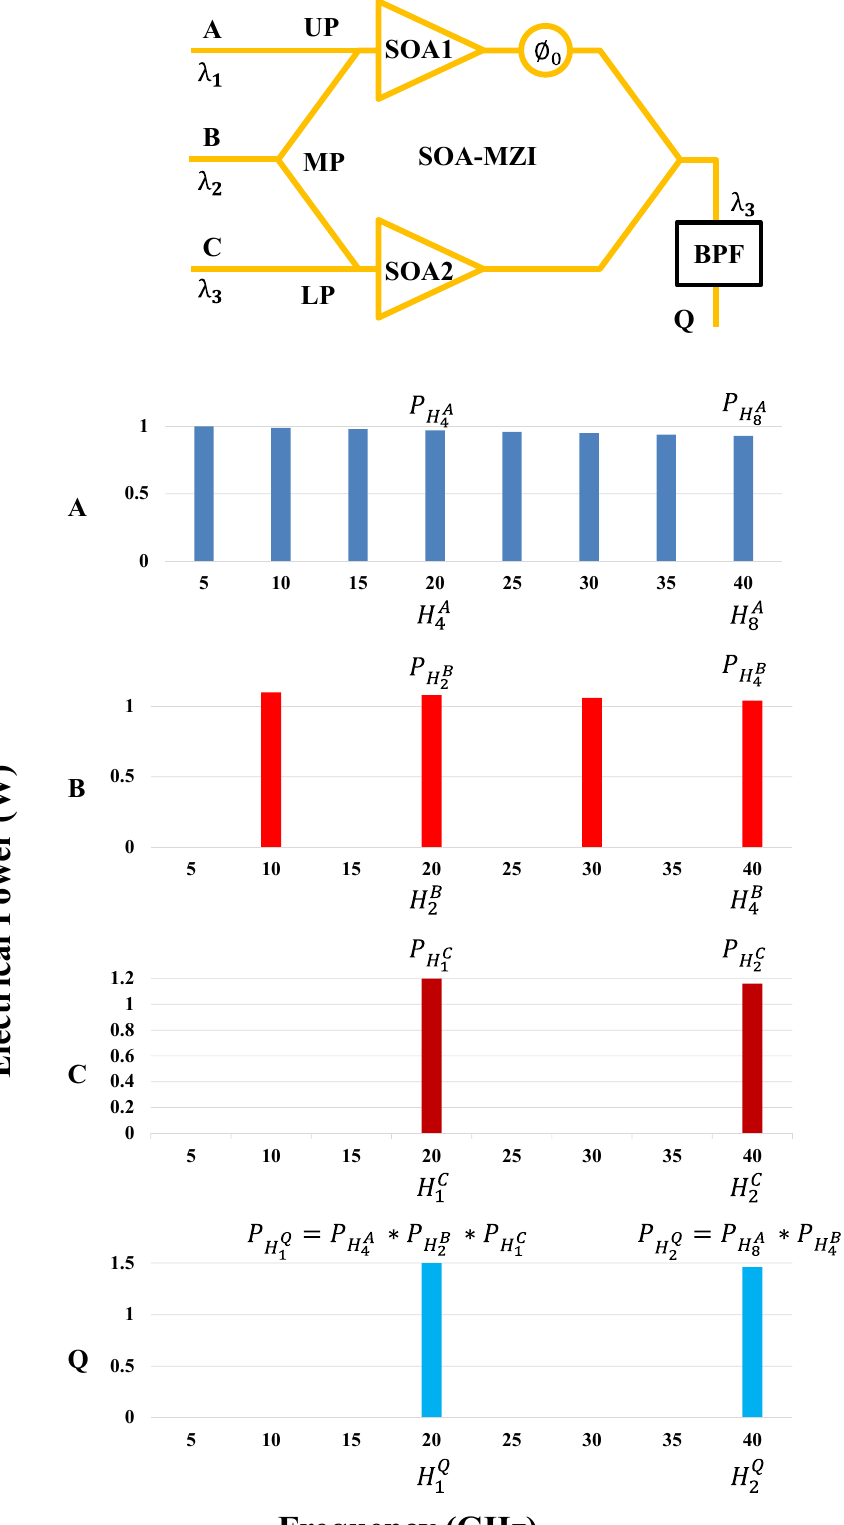
Figure 1. Silhoue tt e of the principle of three-input “AND” gate based on the sampling SOA-MZI Figure 1. Silhouette of the principle of three-input “AND” gate based on the sampling SOA-MZI using its di ff erential modulation architecture. SOA: Semiconductor Optical Ampli fi er, BPF: Band using its differential modulation architecture. SOA: Semiconductor Optical Amplifier, BPF: Band pass Filter, UP: Upper port, MP: Middle Port, SOA-Mach-Zehnder Interferometer (SOA-MZI), LP: Lower Port, A , B , and C are input signals, Q is the output “AND” signal, and ∅ 0 is the phase